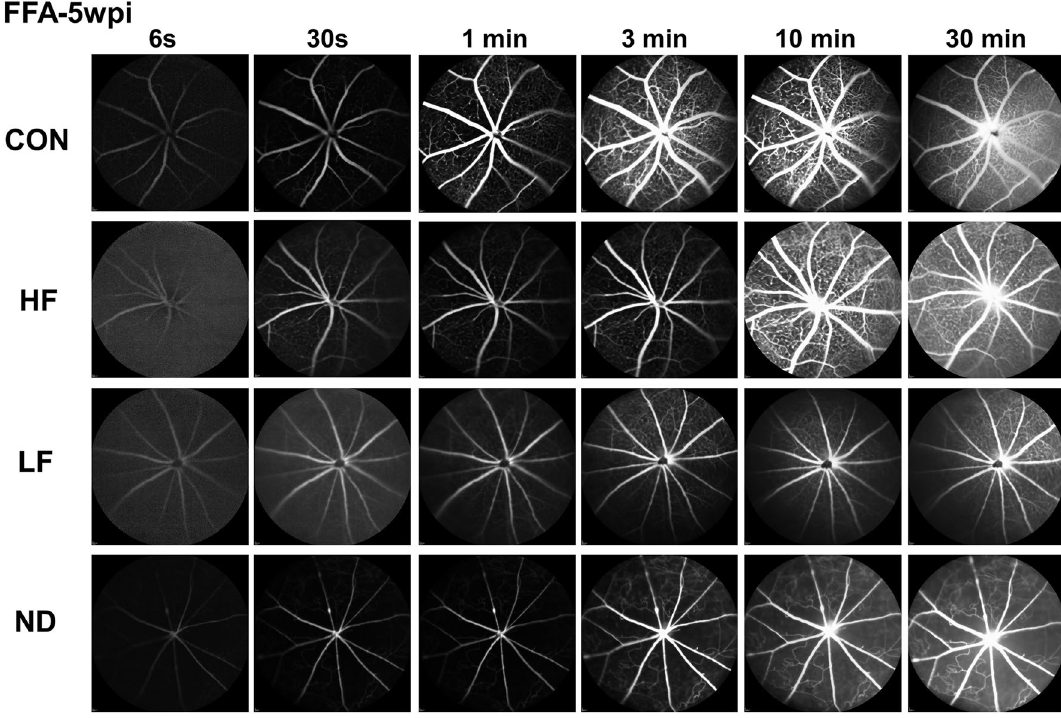
Figure 5. Decreased blood supply in the inner retina: severe in ND, much milder in HF and LF groups . Time series of retinal fundus fluorescein angiography (FFA) images at different time points after fluorescein injection show significantly delayed retinal vessel filling and marked capillary non-perfusion in the ND group, whereas the HF group is similar to the control (CON) group, at 5wpi. Three animals of each group were